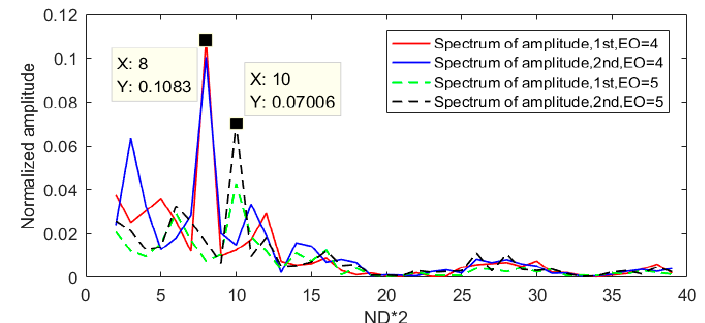
Figure 12. FFT spectra of all blade amplitudes.